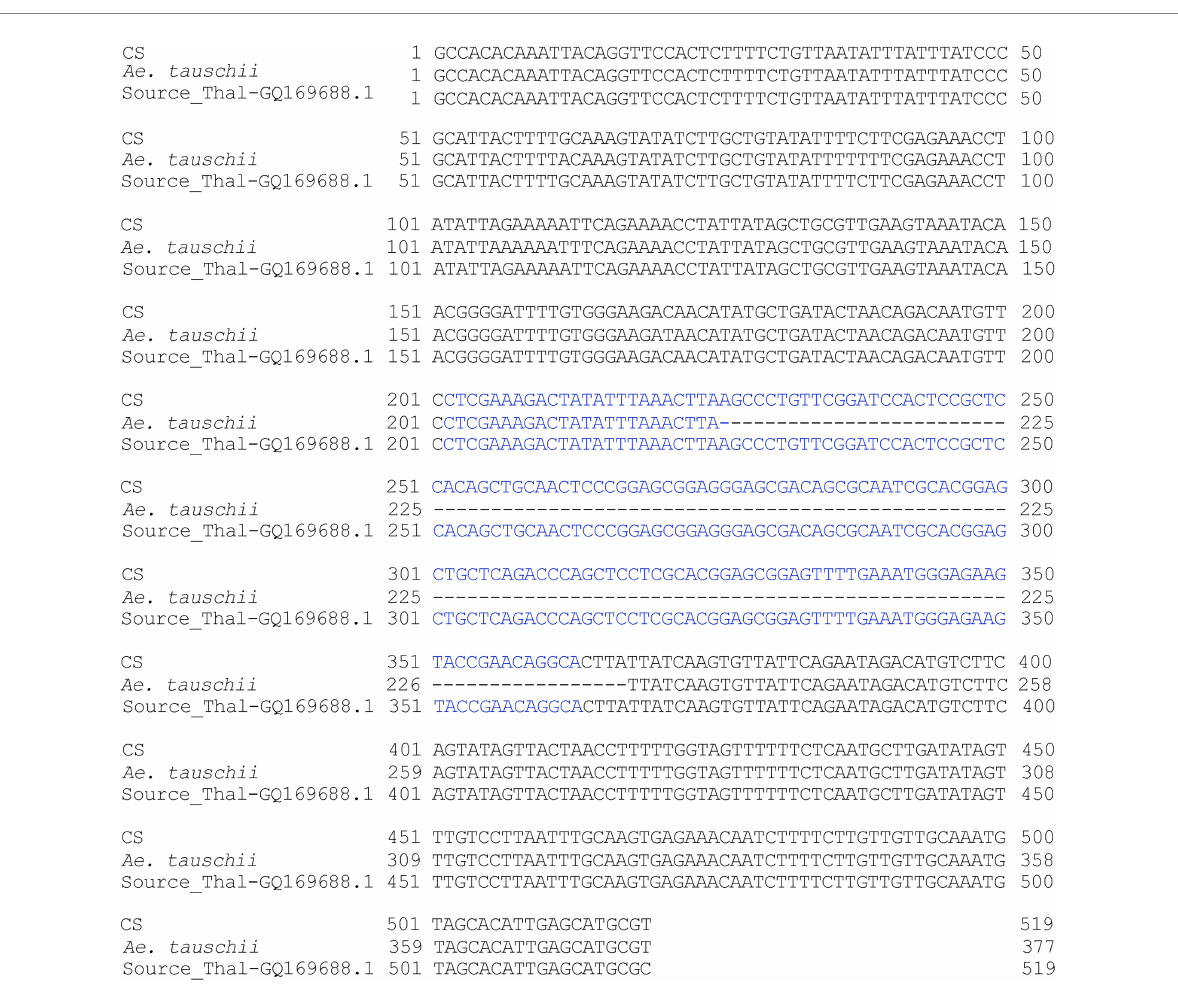
FIGURE 2 Multiple sequence alignment of sequenced amplified fragments (see Figure 3) corresponding to Triticum aestivum cv. Chinese Spring, Ae. tauschii and the best match NCBI database (Thal-GQ169688) bread wheat sequence. The Thalos element is indicated in blue letters, while the flanking sequences are indicated in black letters. The two T. aestivum cultivars Chinese Spring and the NCBI database (bread wheat) have the element, while the Ae. tauschii accession lacked